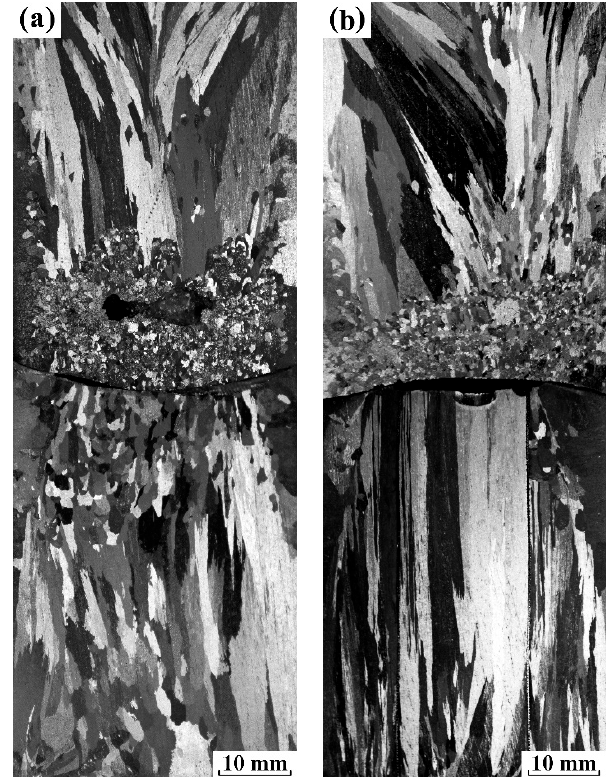
Figure 13. The longitudinal solidification macrostructure in pure aluminum ingots under electropulsing of 700 A with mold of 40 mm in diameter embedded the metal mesh: ( a ) a mesh plate located in the middle of mold and ( b ) a mesh plate embedded along the cross section and a mesh tube embedded along axis.